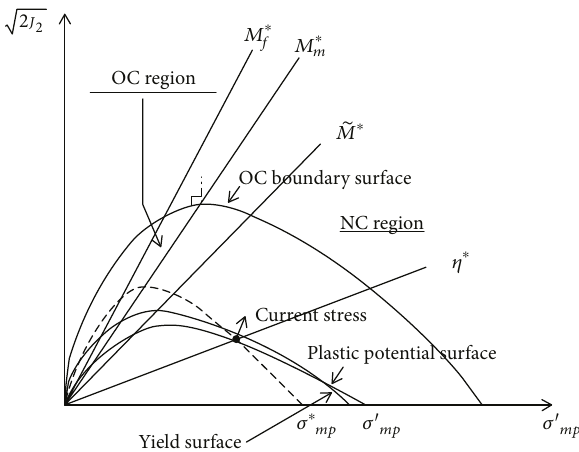
Figure 3: Overconsolidation boundary surface, yield function, and plastic potential function for an isotropically consolidated state.